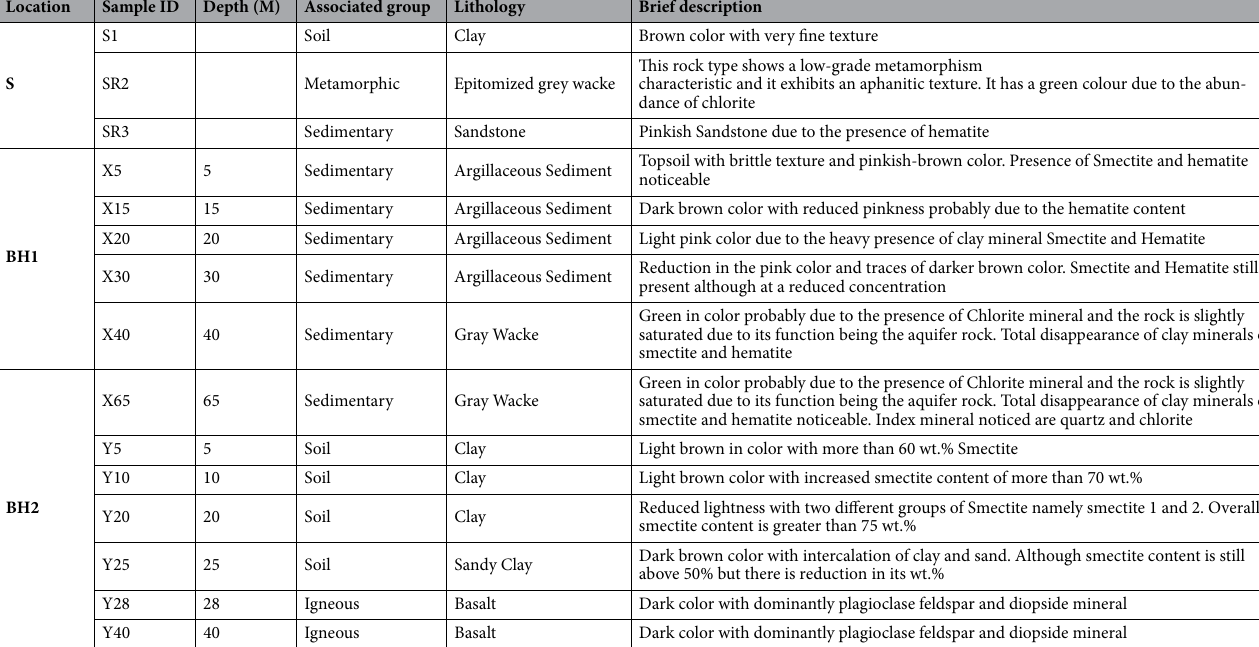
Table 4. Lithologic Description of Sampled Rocks and Soils. S surface soil, SR surface rocks, BH1 borehole 1, BH2 borehole 2.